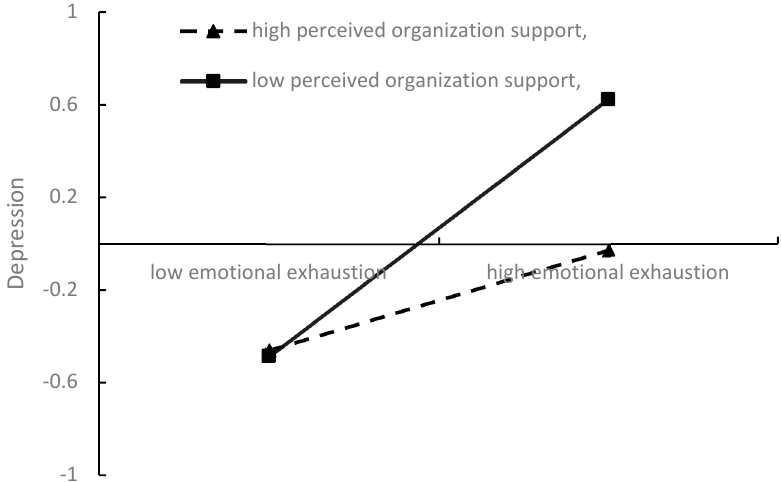
Figure 2. The moderating effect of perceived organizational support.